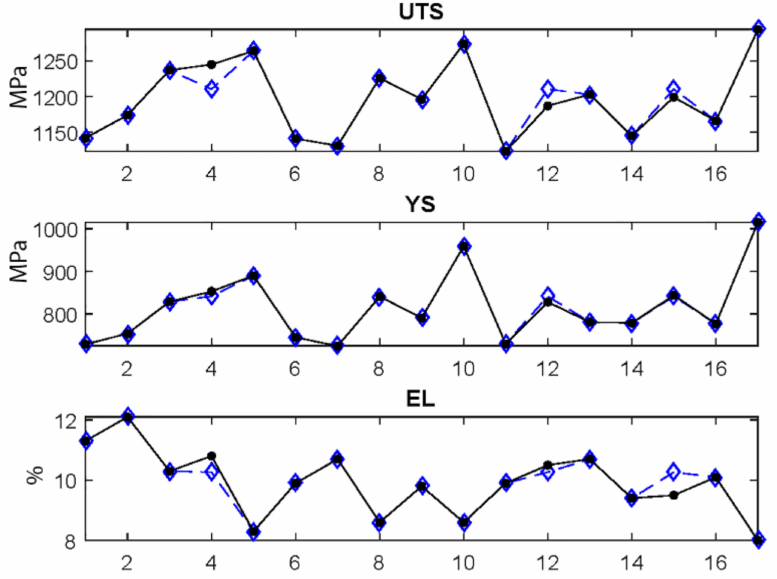
Figure 3. Back-propagation artificial neural network (BPNN) trained model validation. Experimental data (dot-continuous line) and ANN predicted values (diamond-dashed